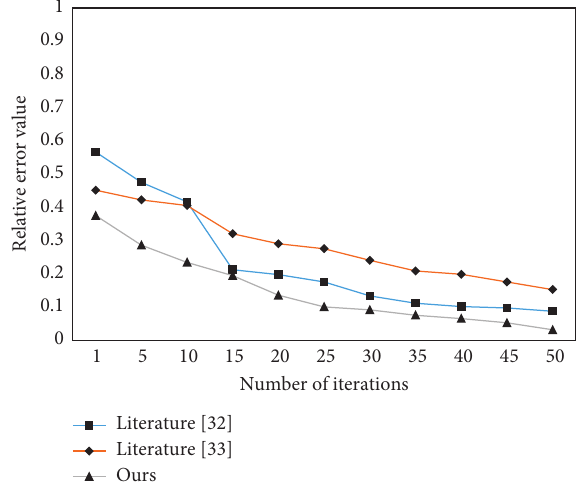
Figure 9: The relative error curves of the predicted values of the three combined forecasting